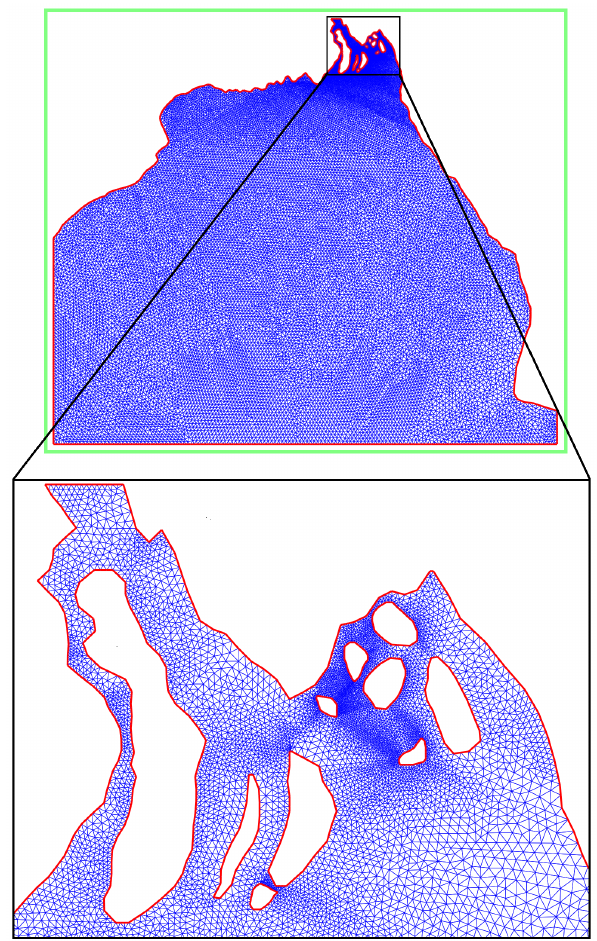
Figure 8. The mesh for the Bay of Bengal region used for Example